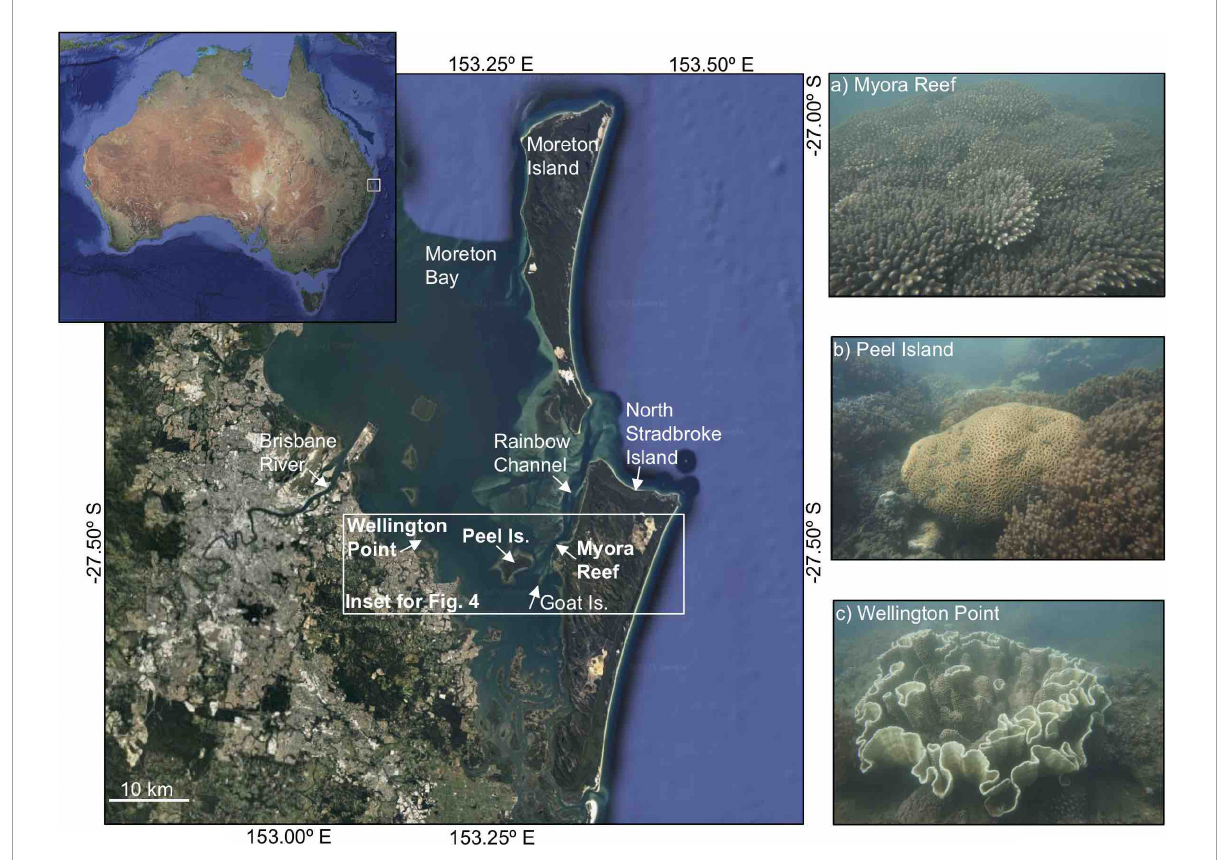
FIGURE1 Map of Moreton Bay, southeast Australia with location of sampling sites in the Bay (Satellite images courtesy of Google Maps). Representative photographs of coral assemblages from: (A) Myora Reef, (B) Peel Island, and (C) Wellington Point (Photo credit: Nicholas M.